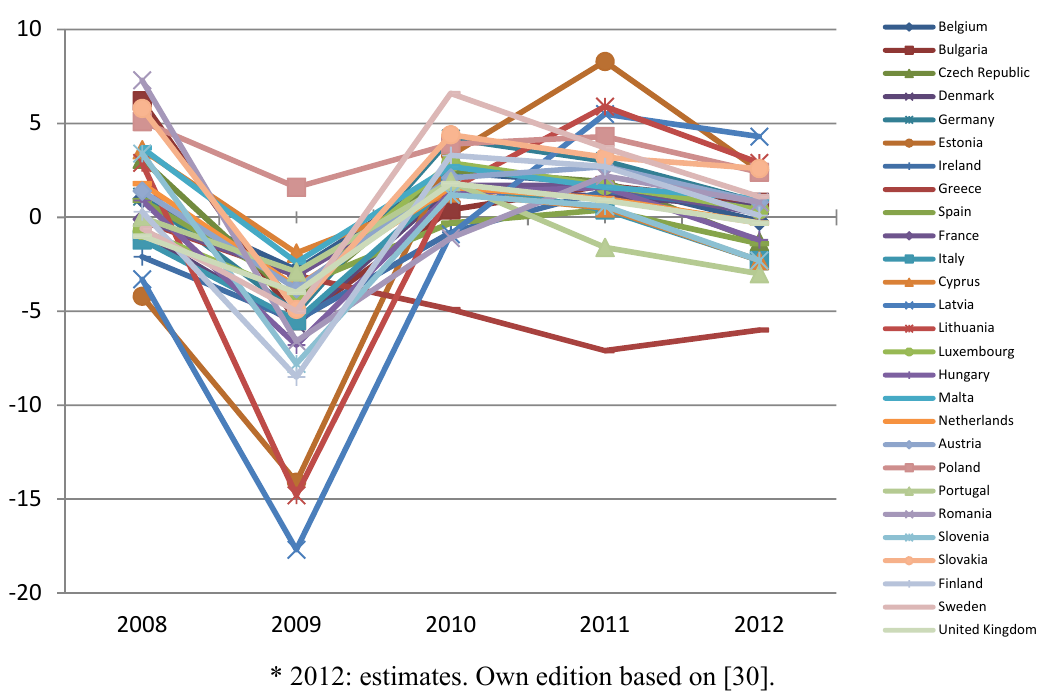
Figure 5. Real GDP growth rate of EU member states, 2008–2012 *, percentage change on previous year.